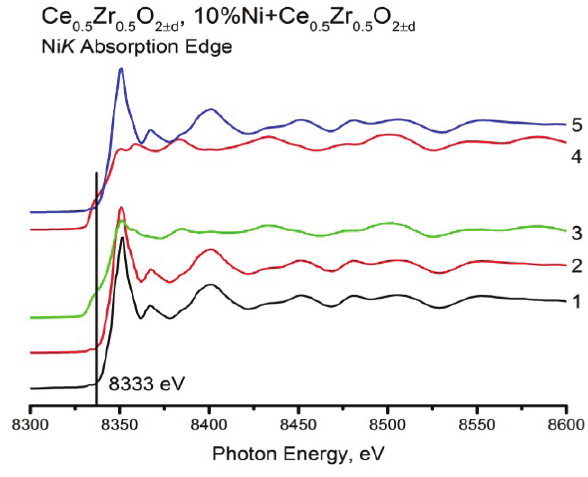
Figure 7: X-ray absorption spectra near Ni K absorption edge: 1 – Ni+ Ce